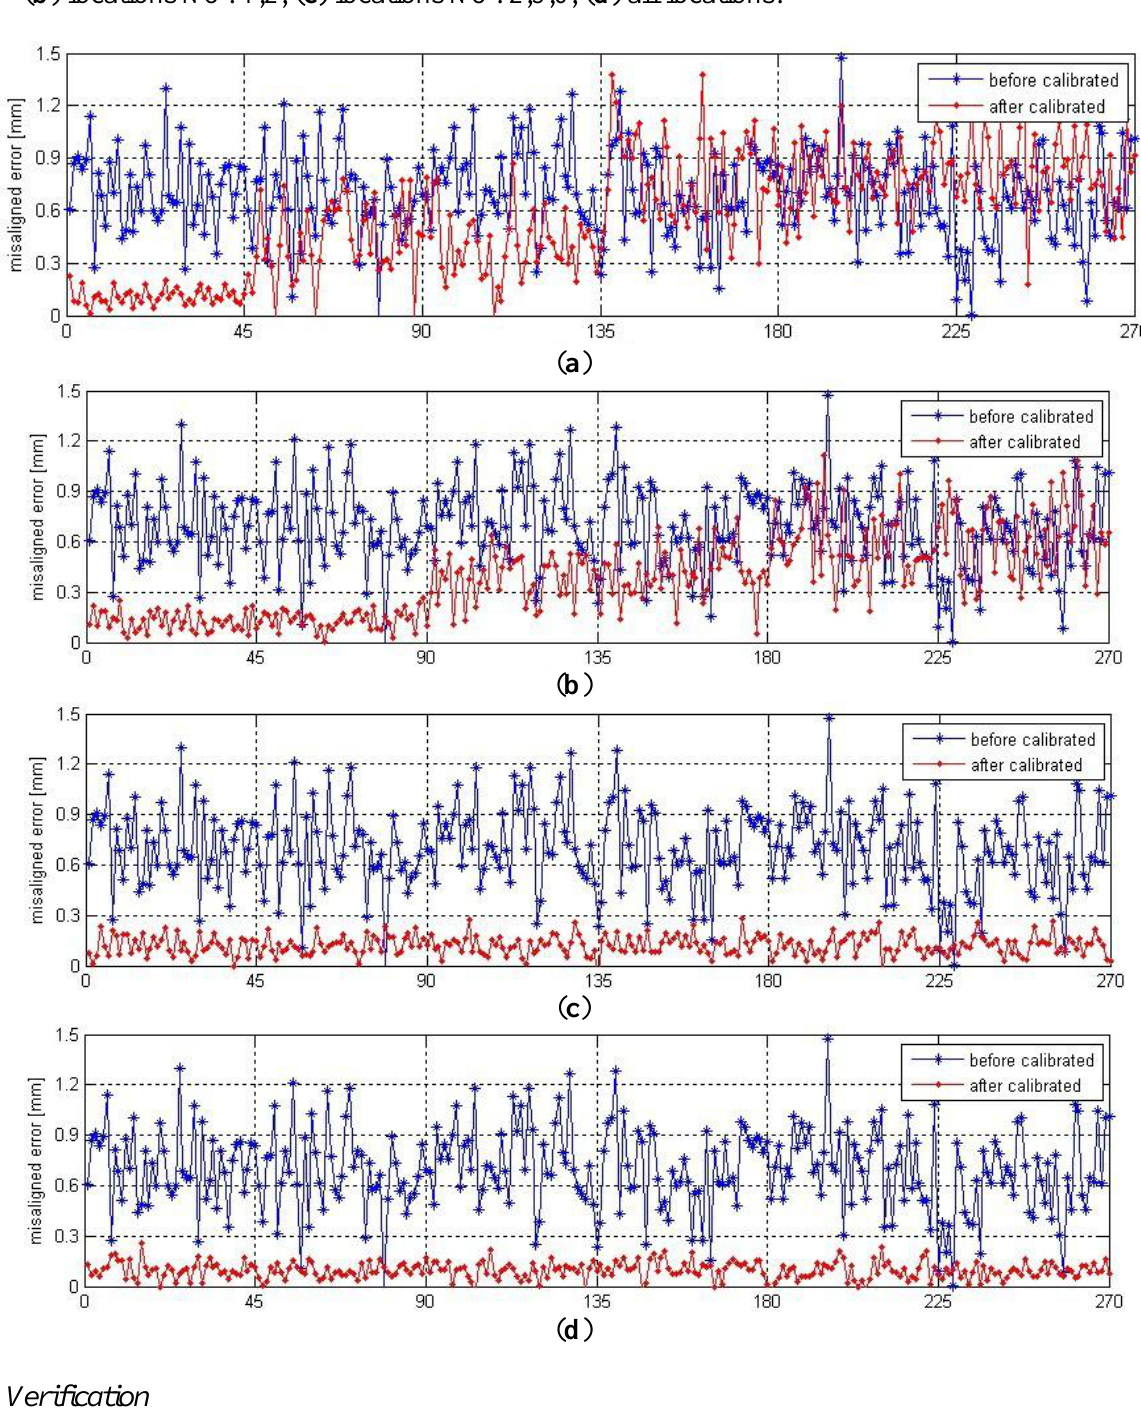
Figure 9. Misaligned errors compensation with four identified parameter sets. Error compensation with parameter identified based on data from: ( a ) location NO.